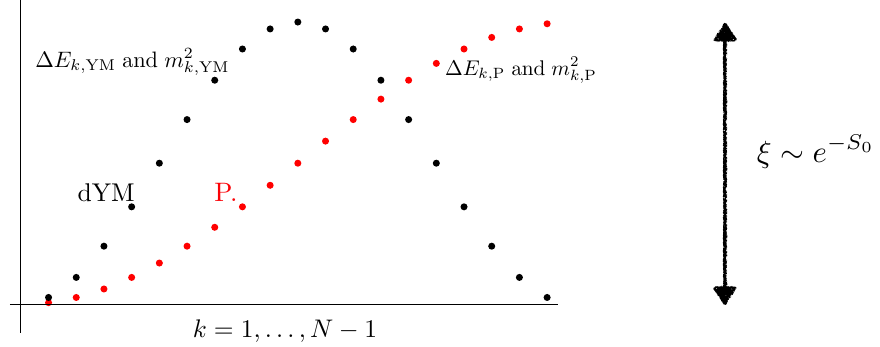
are mass square for photons in full QFT, k